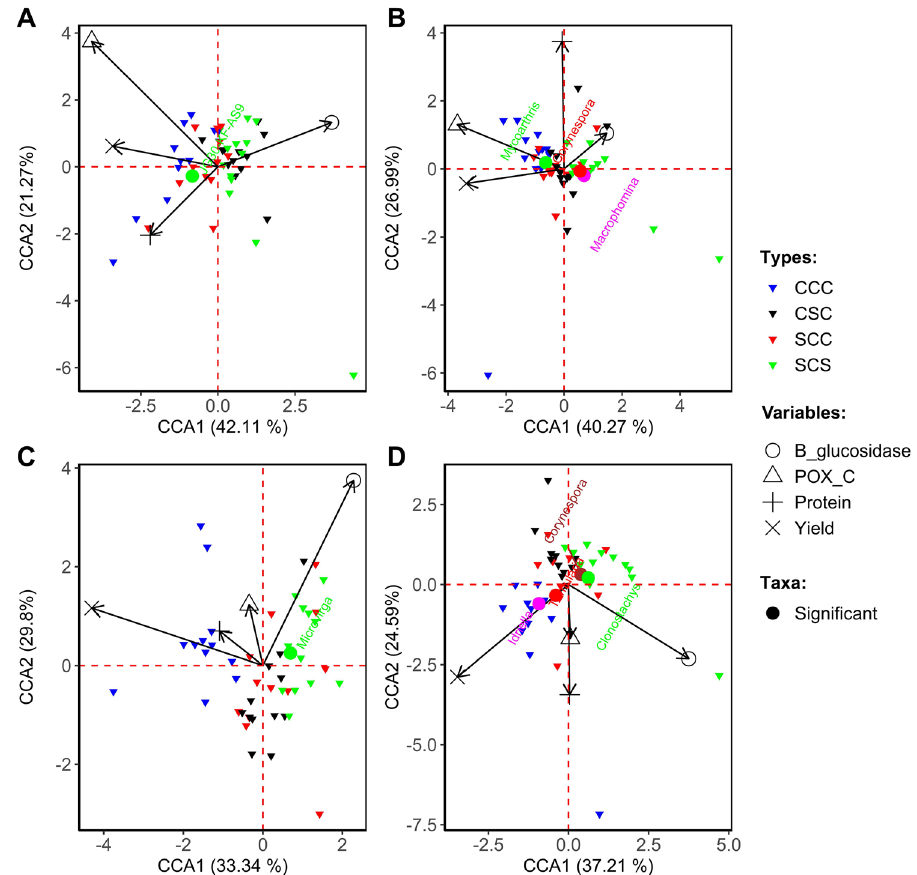
Figure 4. Relationships between operational taxonomic units from different crop rotations and the soil health indicators and soybean yield. A multivariate approach using canonical correspondence analysis (CCA) was used. Only significant taxa are shown by colored-coded circles. Rotation regimes are denoted by color-coded triangles (Treatments) and soil health indicators are denoted by hollow shapes (Indicators). Bacterial ( A ) and fungal ( B ) taxa with differential abundances at the Monmouth location, and CCA for bacterial ( C ) and fungal ( D ) taxa with differential abundances at the Urbana location are